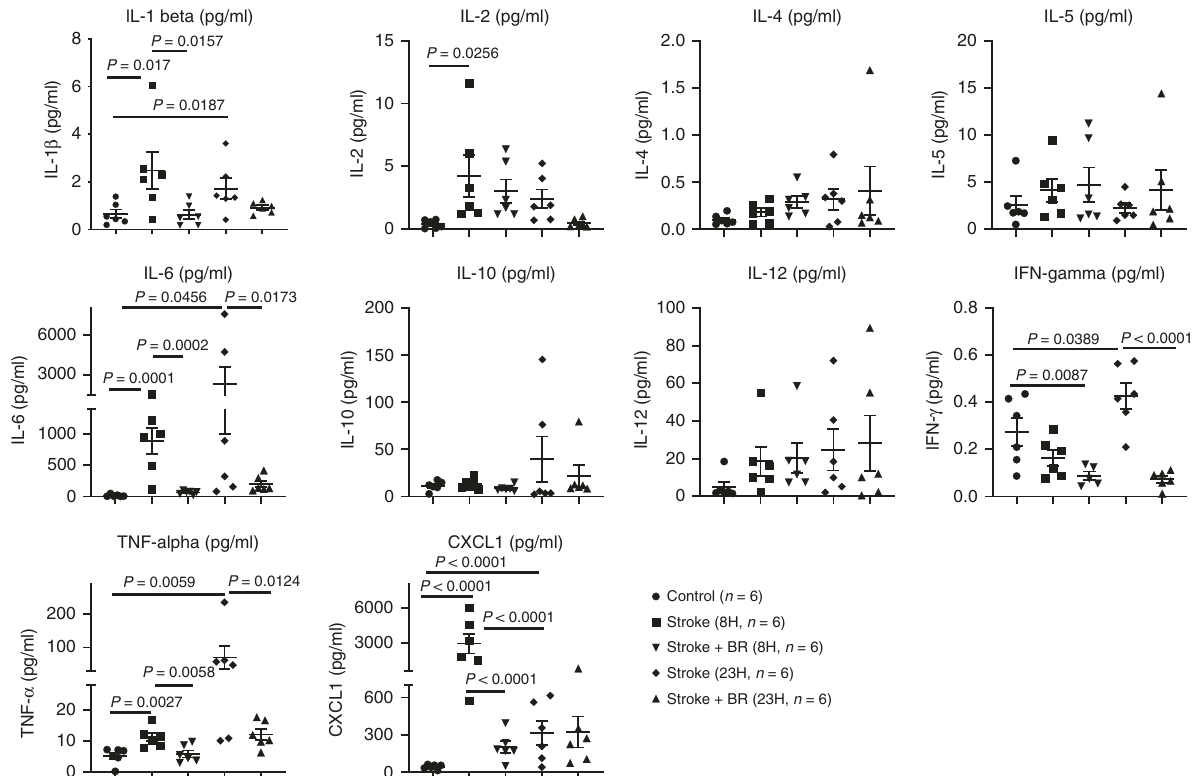
Fig. 5 Blood replacement therapy alters cytokine panel in the plasma of stroke mice. Naive mice (8~12 months old males) serve as a control group (circles, n = 6). Stroke mice (8~12 months old males) underwent tMCAO for 90 min. The occlusion and reperfusion were con fi rmed by a laser speckle imager. Stroke mice were then randomized into four groups: two groups being killed at 8 (squares, n = 6) and 23 h (diamonds, n = 6) post stroke; two groups receiving blood replacement (BR) therapy and being killed at 8 (down-pointing triangles, n = 6) and 23 h (up-pointing triangles, n = 6) post stroke. Then plasma was collected for the analyses of proin fl ammatory cytokine panel including IL-1 β , IL-2, IL-4, IL-5, IL-6, IL-10, IL-12, IFN- γ , TNF- α , and the chemokine, CXCL1. Data were presented as means± SEM. One-way ANOVA followed by post hoc Fisher ’ s unprotected least-signi fi cant difference for multiple comparison tests. Source data are provided as a Source Data fi